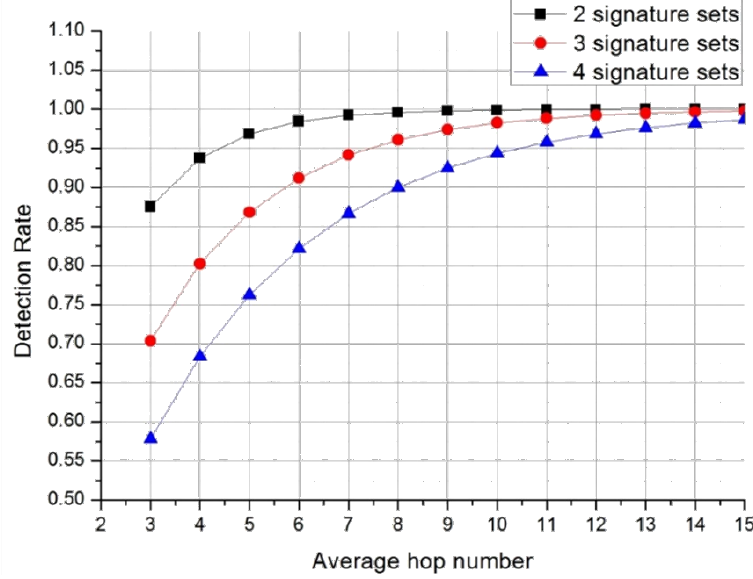
Figure 10. Detection rates when attack signatures are